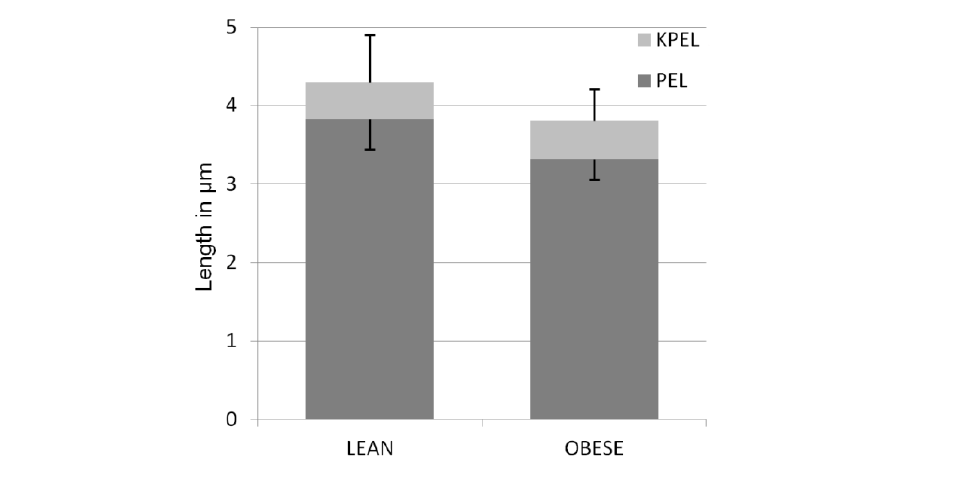
Table 1. Shapes of PELs.